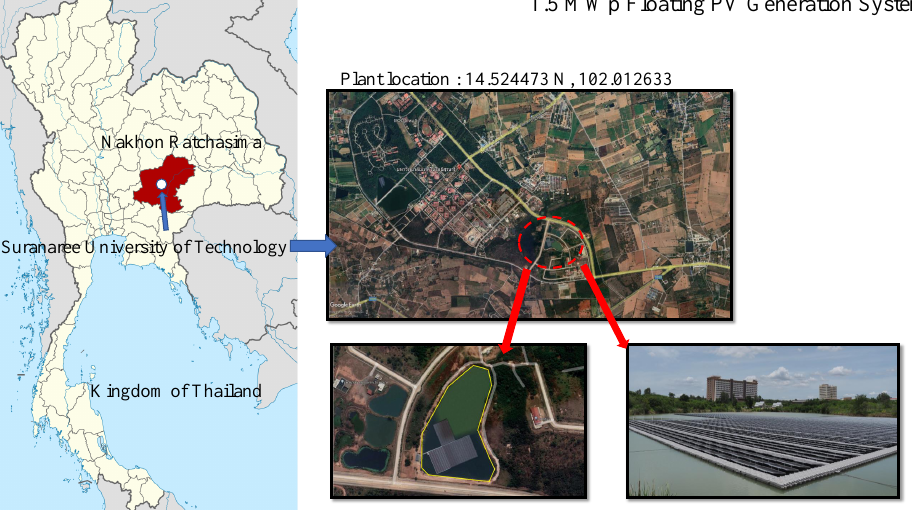
Figure 1. The installation site of the 1.5 MWp floating PV power plant is located at 111 University a population of 30,000. The selected location has a tropical wet and dry or savanna climate type. Because the plant is located in a tropical area, it has great solar